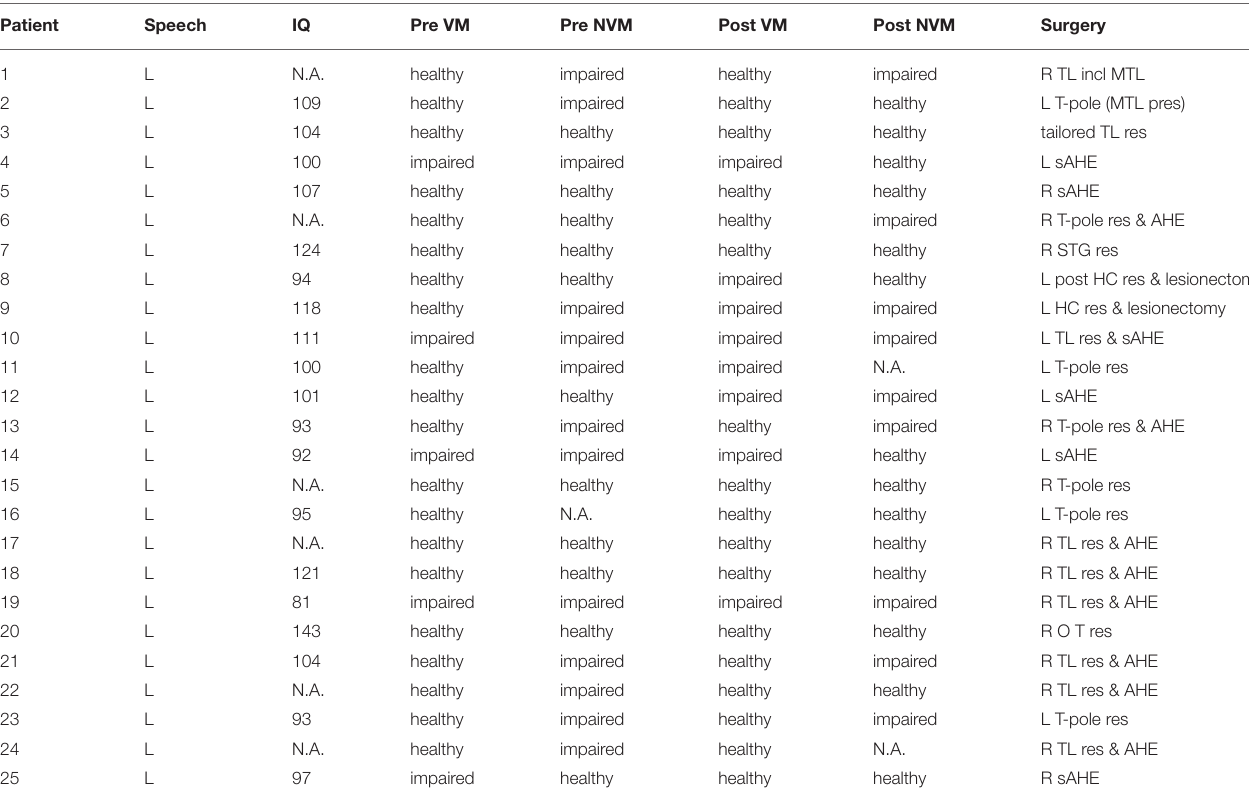
TABLE 2 | Memory performance results.